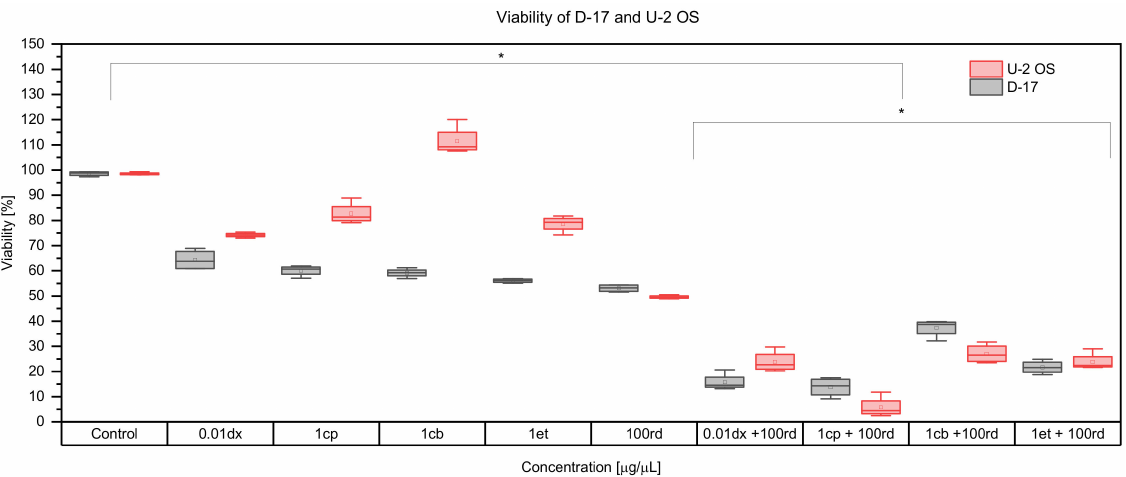
Figure 2. The effect of risedronate sodium on cytostatic activity of doxorubicin, cisplatin, carboplatin, etoposide per se and in combined administration. dx—doxorubicin, cp—cisplatin, cb—carboplatin, et—etoposide, rd—risedronate sodium, * ( p < 0.05). 3.3. The Apoptotic Effect of Combined Use of Risedronate Sodium and Cytostatic Drugs The study demonstrated that the pro-apoptotic effect in D-17 and U-2 OS cell cultures after combined administration of the cytotoxic drugs (doxorubicin, cisplatin, carboplatin and etoposide) and risedronate sodium may be described as synergy. The strongest apopto- sis in both cell cultures was caused by 0.01 µ g/mL doxorubicin combined with 100 µ g/mL risedronate sodium or 1 µ g/mL cisplatin and the same dose of risedronate sodium. The apoptosis rate in the cultures treated with these combinations was 89.21 ± 4.07% and 88.70 ± 6.67% for the canine OS cell line, and 80.91 ± 2.83% and 94.66 ± 4.86% for the